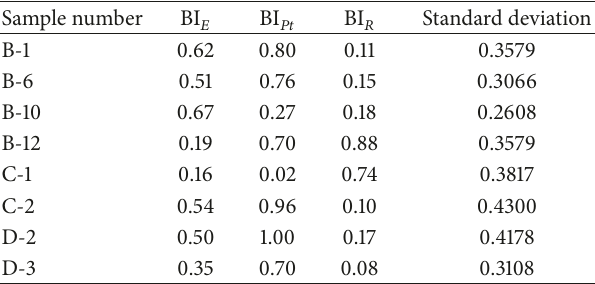
Table 2: Brittleness indexes with large dispersion